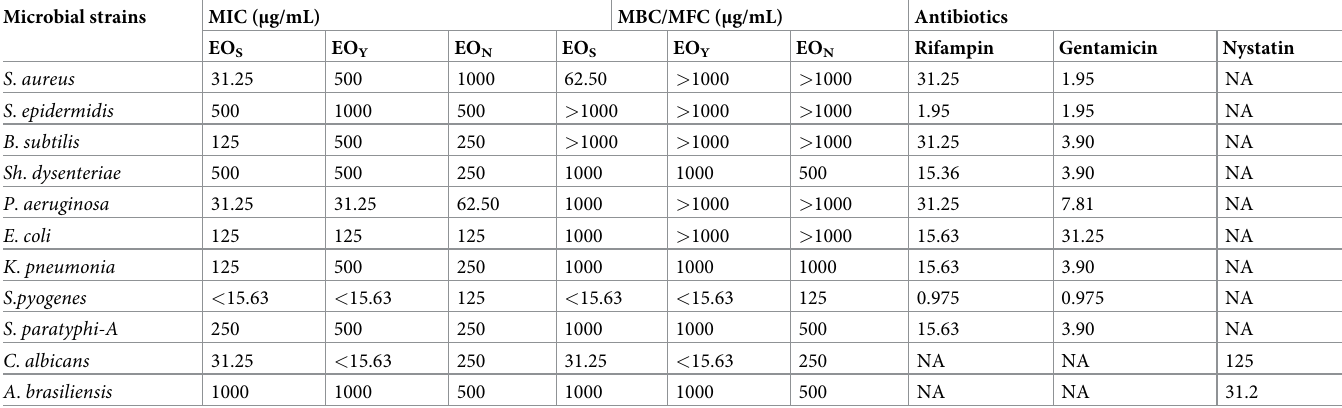
Table 10. MIC, MBC, and MFC values of R . damascena EO at the crop sites and of the antibiotics against some standard microbial strains. Microbial strains MIC ( μ